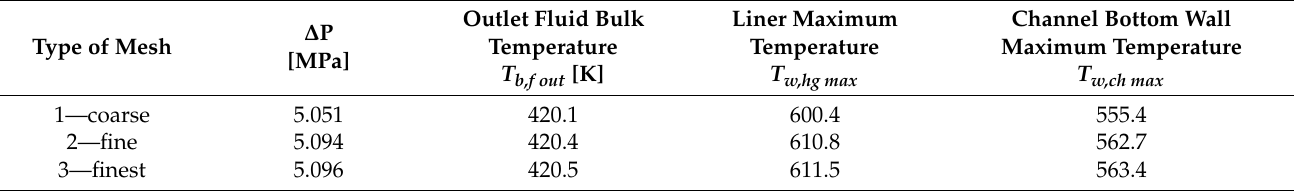
Table 2. Results of grid-independence analysis.